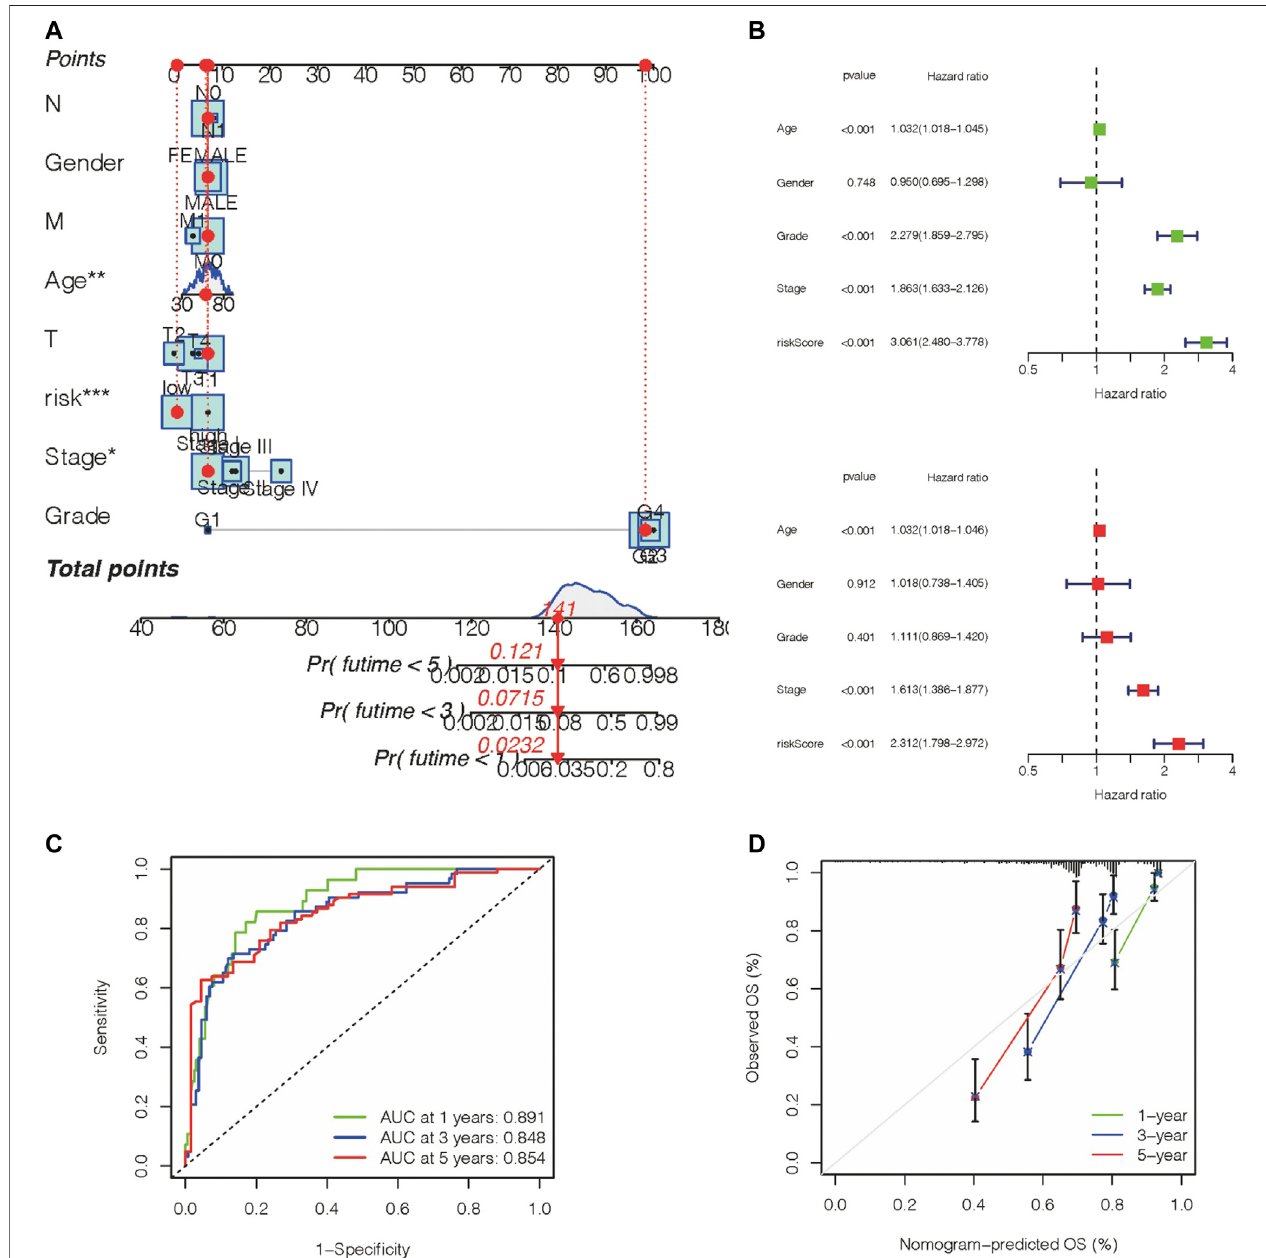
FIGURE 6 | Construction of a nomogram with a predictive value for prognosis. (A , B) A nomogram was constructed based on the prognosis gene panel and other relevant features. (C) AUC value of the gene panel for 1-year, 3-year, 5-year prognosis prediction in the KIRC database. (D) Calibration plot designed for the KIRC